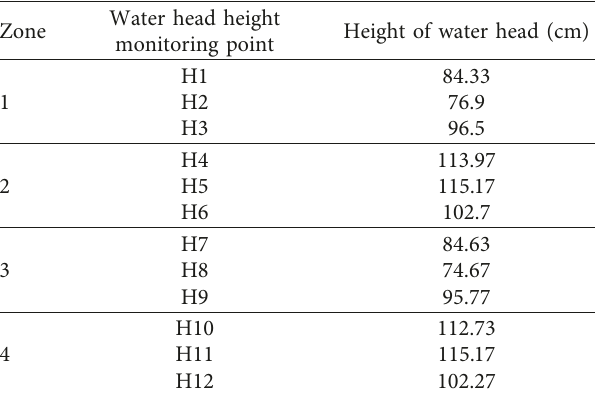
Figure 8: Fitting diagram of experimental head value and nu- merical simulation head value. Table 2: Head height values of water head monitoring points in different areas.